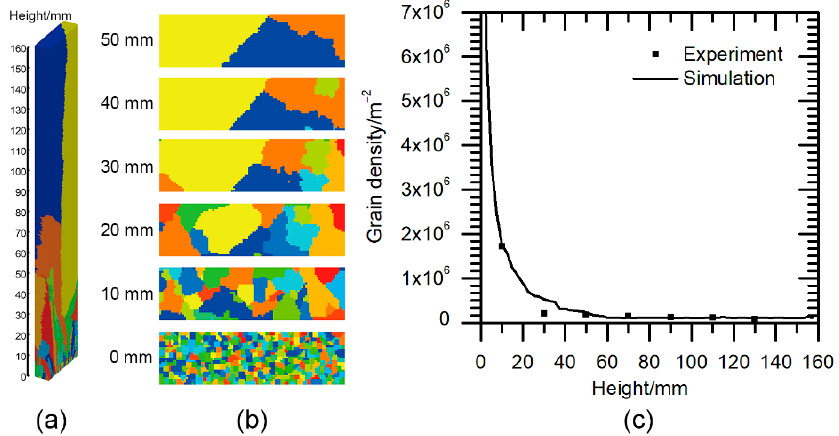
Figure 9. ( a ) Grain structure of the specimen; ( b ) Grain structure at each section with different heights, starting from bottom with an interval of 10 mm; the height of the section is shown in the left side of each section; ( c ) Simulated and experimental grain density with different